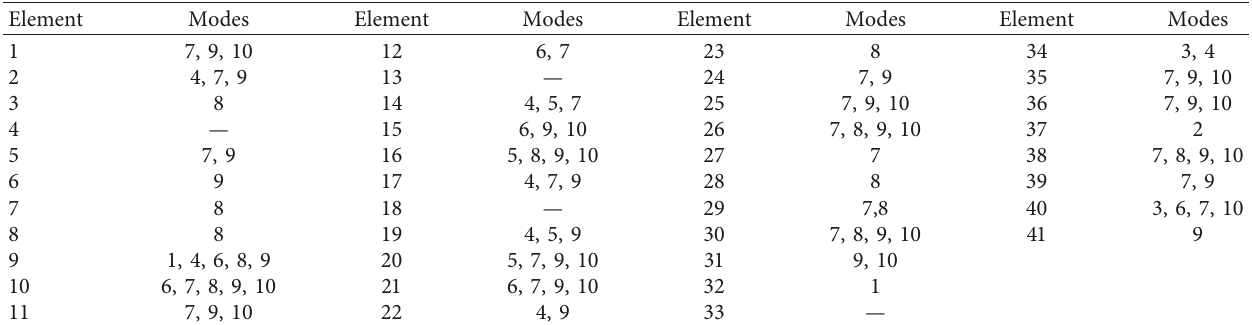
Table 4: Determined sensitive modes of all